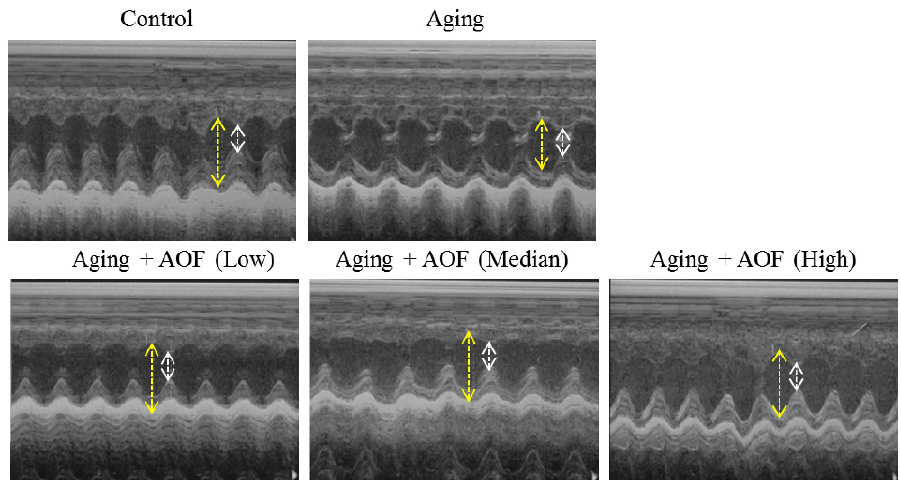
Figure 1. Echocardiography findings. Representative echocardiographic M-mode images from rats with D -galactose and Alpinate Oxyphyllae Fructus (AOF) treatment. AL (AOF low), AM (AOF medium), AH (AOF high) represent the doses of 50, 100 and 150 mg of Alpinate Oxyphyllae Fructus per kg BW (Body weight). The long yellow arrow indicates cardiac diastole, and the short white arrow shows cardiac systole.